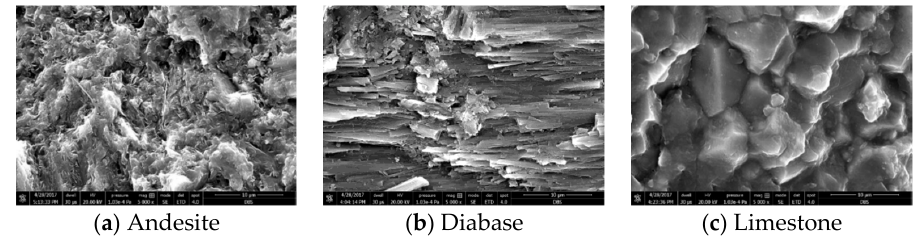
Figure 7. Scanning electron microscope photos of three kinds of aggregates (5000×).